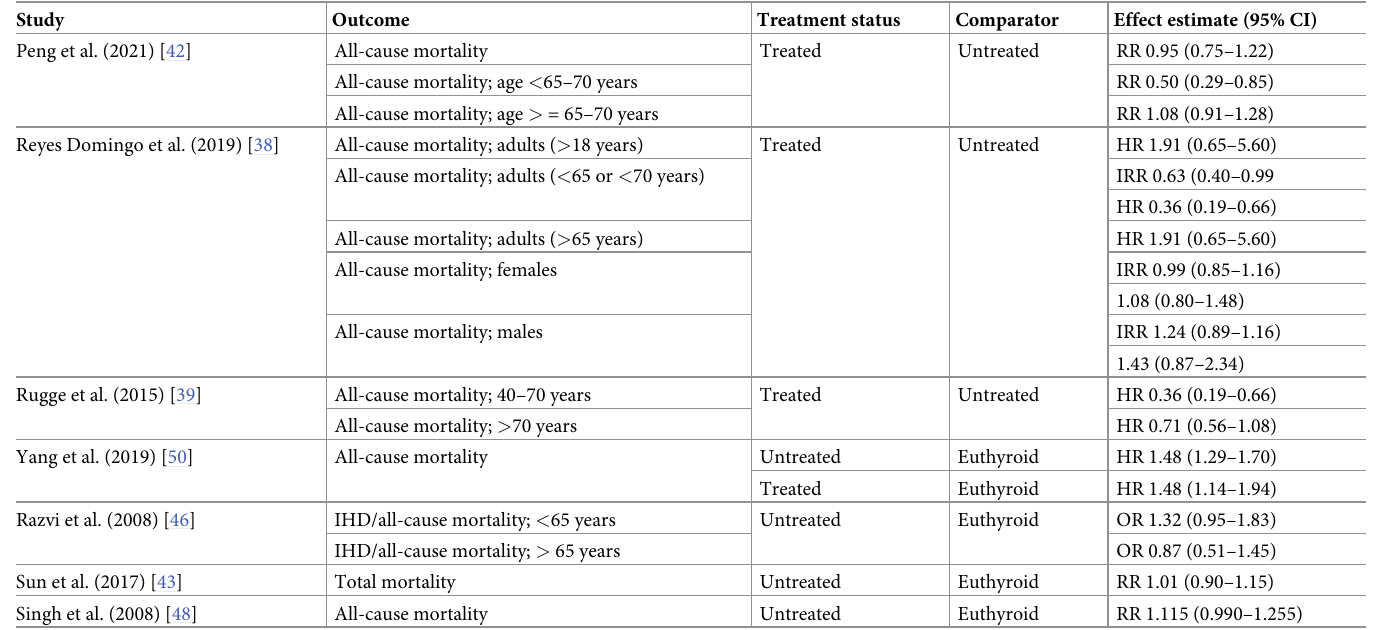
Table 3. Review findings on all-cause